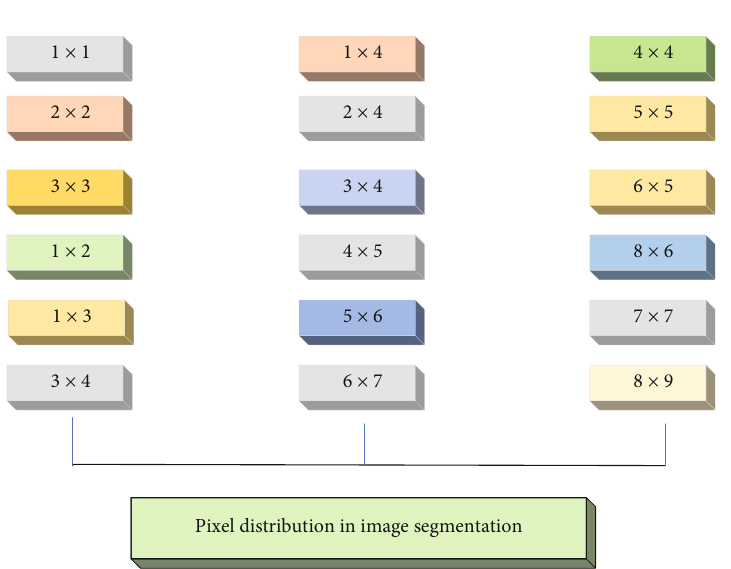
Figure 2: Region-based segmentation method.